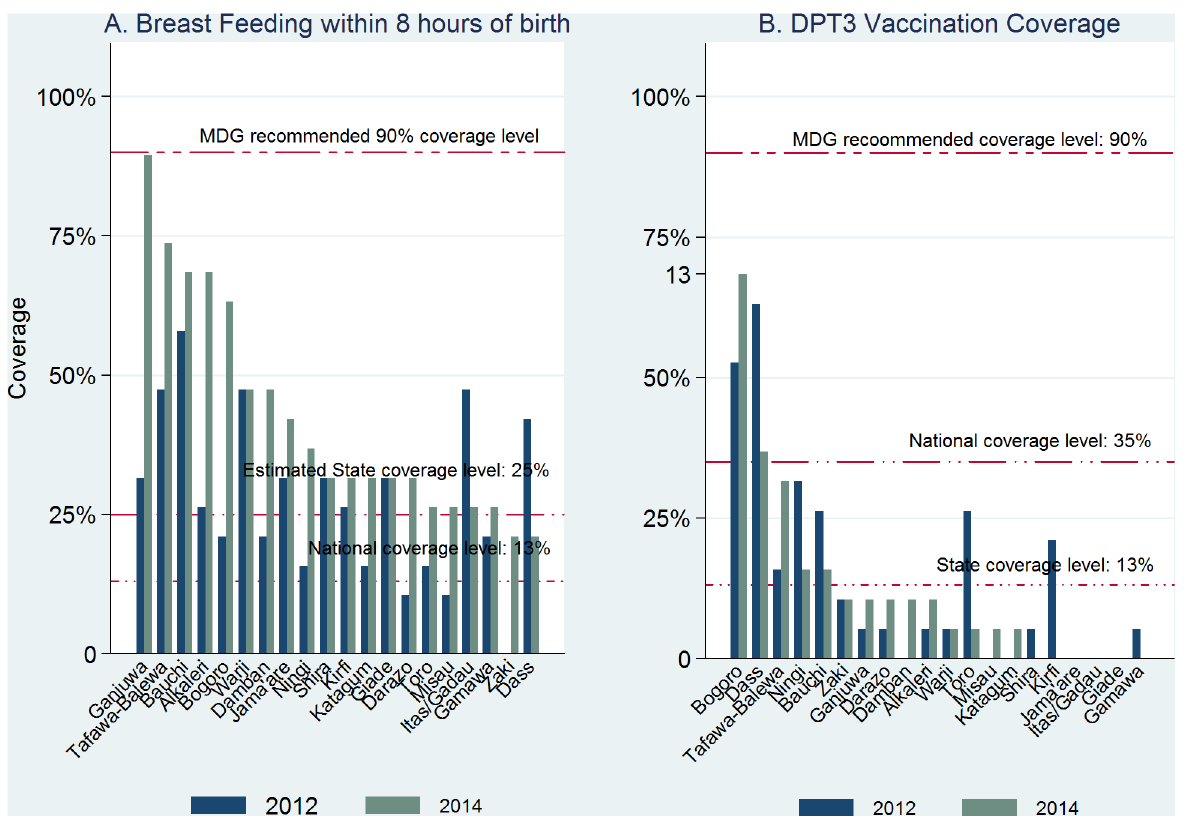
Fig 4. Early childhood: Coverage of breast feeding and DPT3 vaccination by LGA, 2012 and 2014.